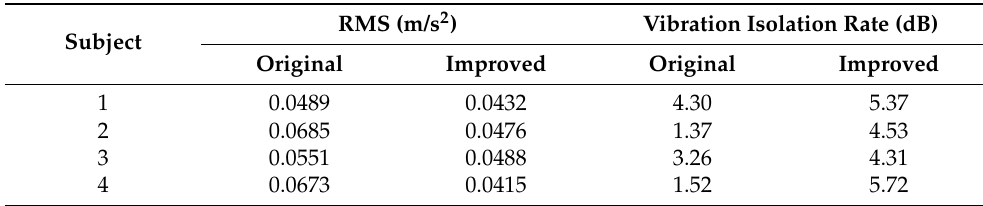
Table 7. RMS and vibration isolation rate of the original sponge and the improved sponge under crushing